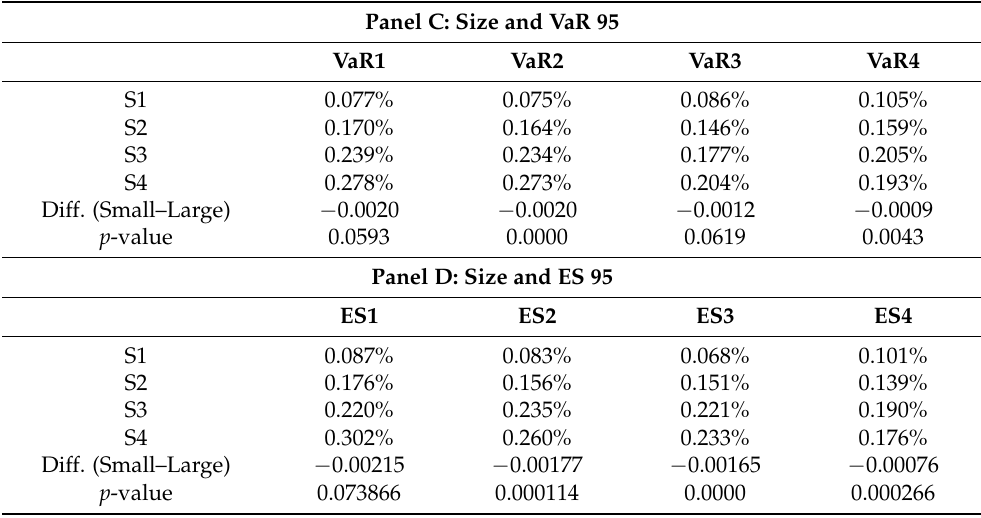
Table 4. Portfolio returns of size, VaR and ES at 95% level of significance. The table represents the average returns of 24 portfolios formed oversize, and VaR and 24 portfolios created oversize and CVaR at 95% level of significance. A total of 527 listed firms is analyzed, from which we dropped firms with negative book-to-market equity. Firms with missing values and no data were dropped. S1 to S5 represents small to large portfolio stocks, VaR1 to VaR5 represents low VaR to high VaR stocks and CVaR1 to CVaR5 means low to high CVaR stocks. Panel C: Size and VaR 95